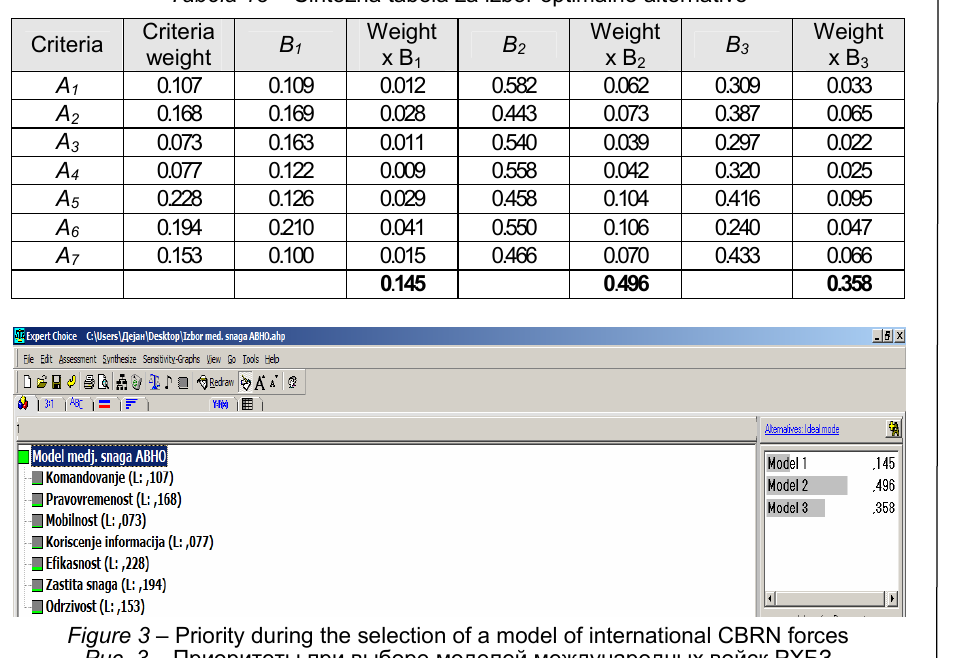
Table 13 – Synthesized table for the selection of the optimal alternative Таблица 13 – Сводная таблица выбора оптимальных альтернатив Tabela 13 – Sintezna tabela za izbor optimalne alternative